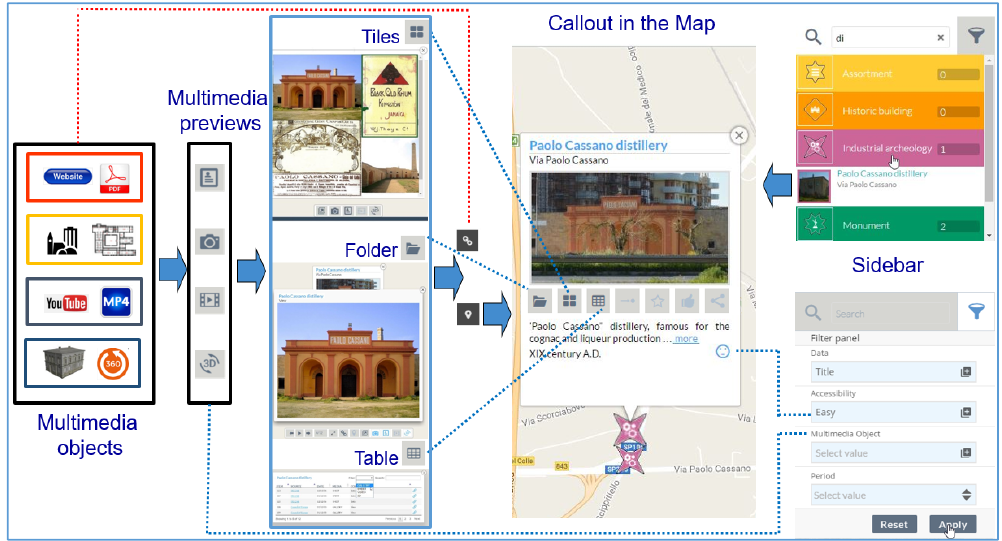
Figure 6. Interconnections between knowledge—expressed through multimedia objects—and PoI.s.